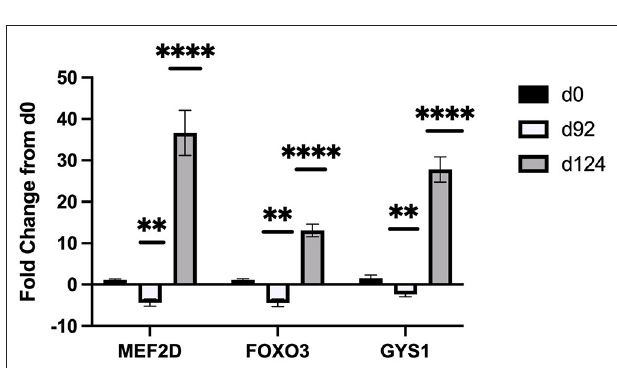
FIGURE 4 | Fold change in mRNA expression of transcription factors (ZFP423, PPARG, SREBP1c), activators (PGC-1A, SCAP), and fatty acid transporters (FABP4, FFAR4) at d 92 and d 124 compared to d 0 ( n = 4/time). Differences are noted (* P < 0.05; ** P < 0.01; *** P < 0.001; **** P < 0.0001) in comparison to d 0.